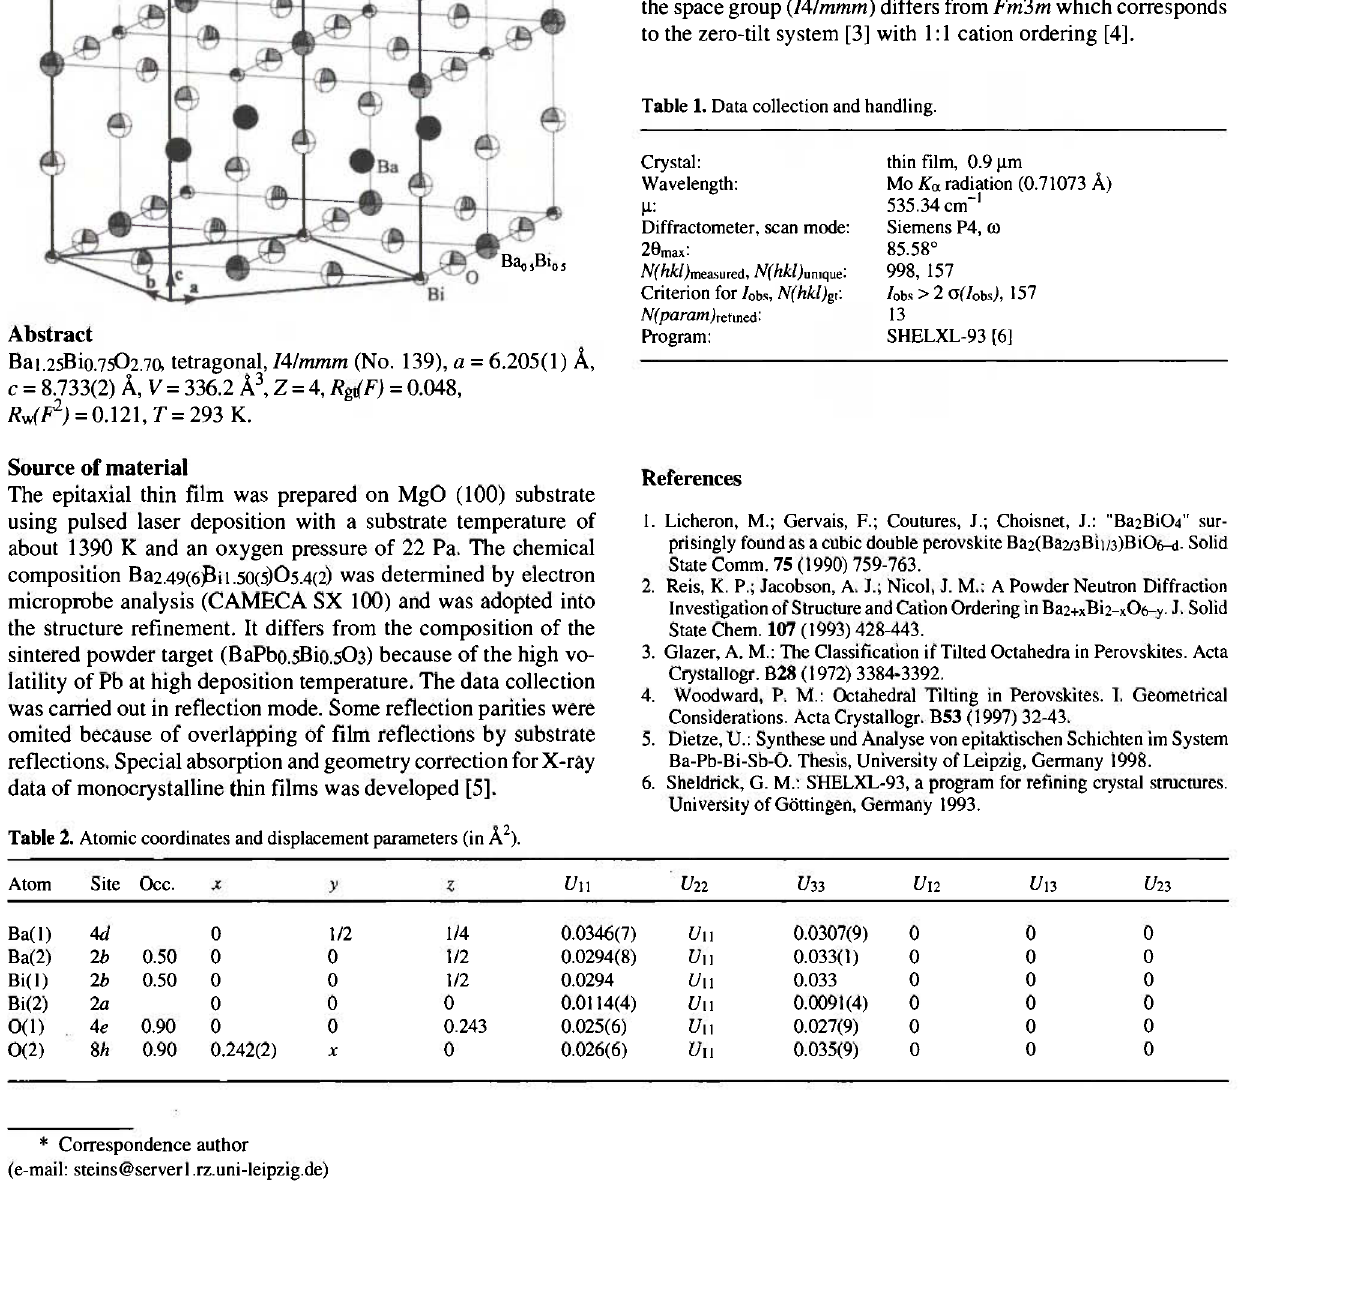
Discussion Ba2(Bao.5Bio.5Bi)06-d single crystal thin film shows a double perovskite cell [1,2] with an ordering of 0.5 Ba + 0.5 Bi and Bi on two different octahedral sites and only Ba on the perovskite A site. The directions of the lattice axes of the pseudocubic cell are parallel to MgO <100>. The cell is slightly compressed perpen- dicular to the substrate surface (parallel to_the c axis). Therefore, the space group ( IAImmm ) differs from Ftrßm which corresponds to the zero-tilt system [3] with 1:1 cation ordering [4].